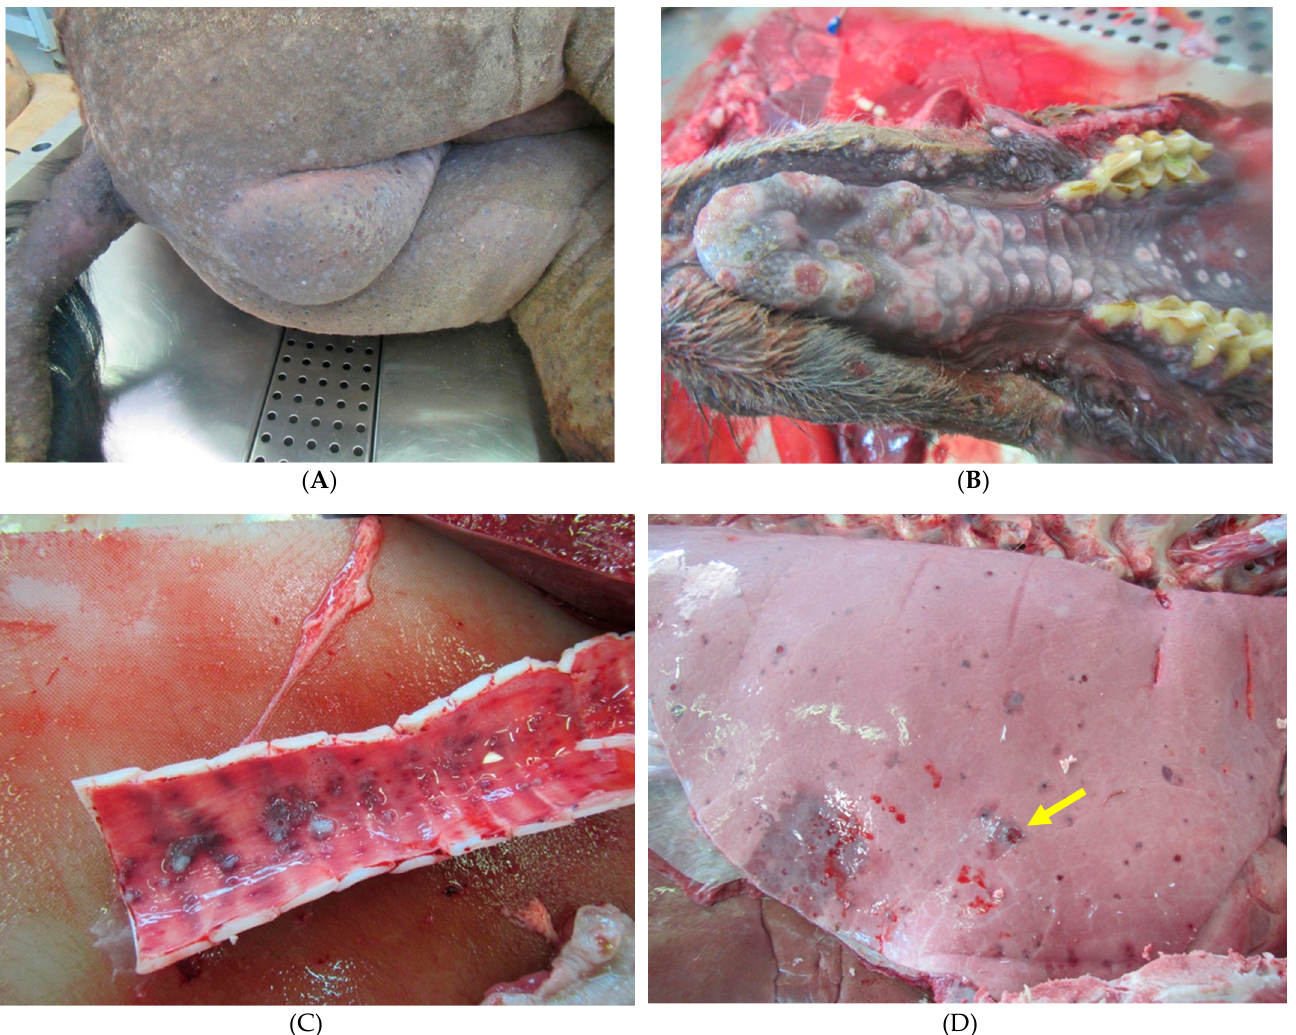
Figure 1. ( A ) Classical generalized camelpox lesions on the rear side of a camel as raised circular plaques (D1621/20). ( B ) Multiple pock erosions at the palate (D2053/20). ( C ) Pock lesions in the tracheal mucosa as raised circular nodules (D1621/20). ( D ) Pock nodules (yellow arrow) well circumcised, round and slightly raised in the lung parenchyma (D1795/20).